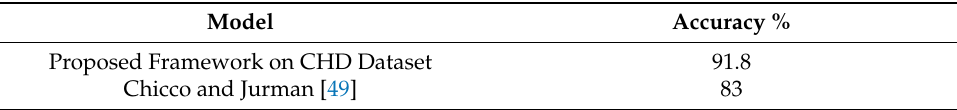
Table 7. Results for the proposed framework on CHD